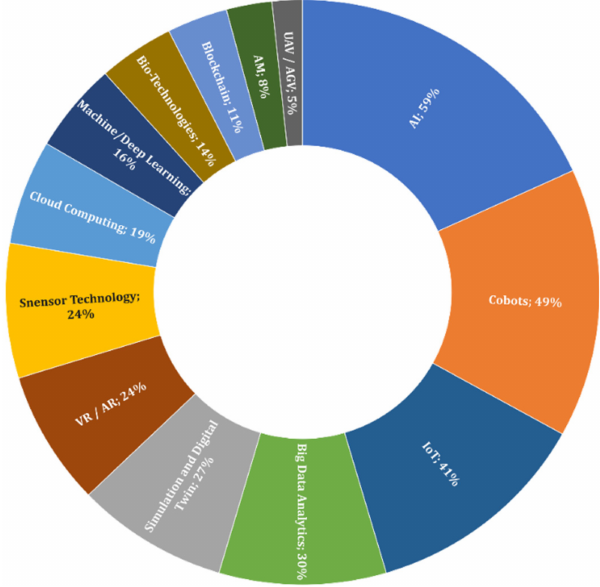
Figure 8. Supporting technologies in smart logistics of Industry